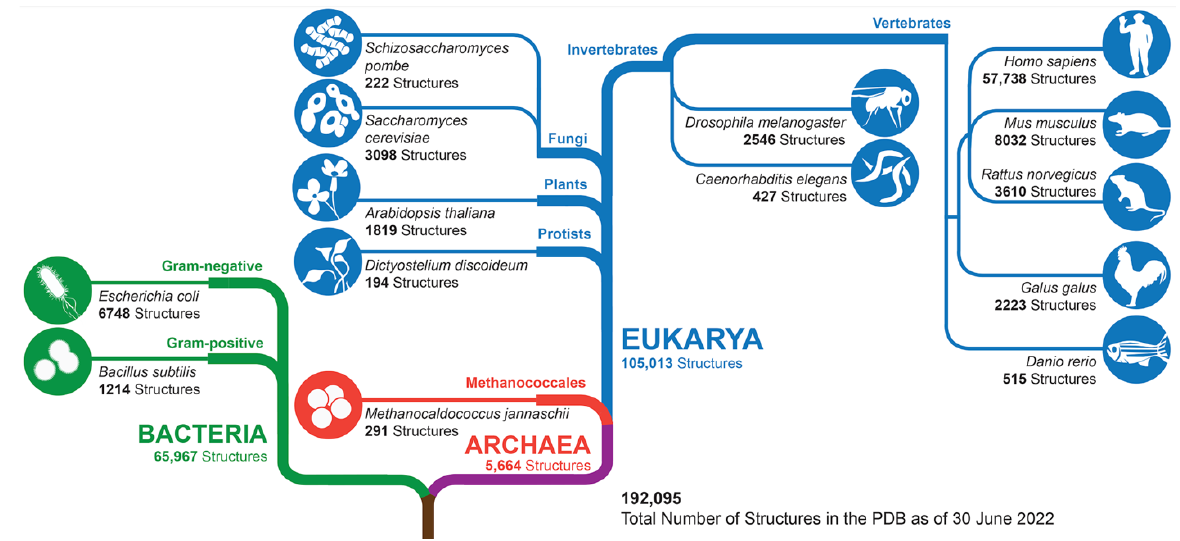
Figure 7. Phylogenetic Tree showing PDB holdings (as of mid-2022). Within each of the three branches, PDB structure totals are provided for selected organisms. N.B.: The PDB also houses 3D structures that solely contain nucleic acids (DNA, RNA, DNA-RNA hybrids, etc.) and/or viral proteins or human-designed proteins, which collectively accounted for ~8% of archival holdings as of mid-2022.